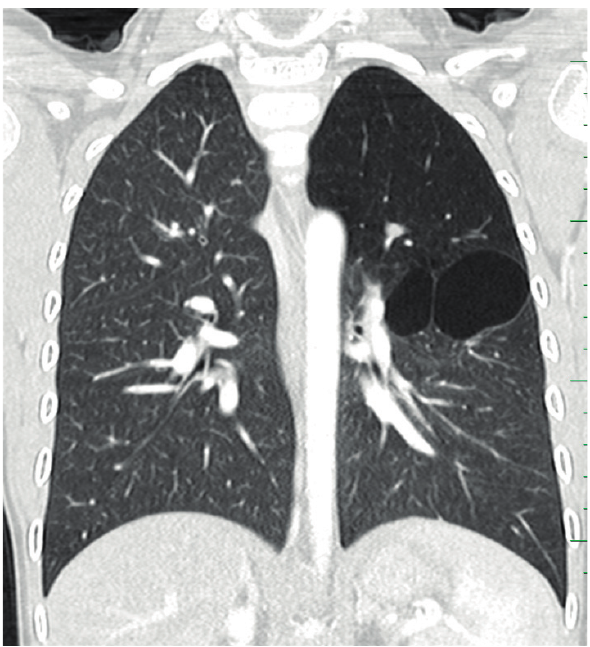
Fig. 2. Multiple large cysts measured > 2 cm in the left upper lobe (LUL), with adjacent area of hypoattenuation, mixed lesion with CPAM 1 and CLO component. Coronal postcontrast CT reconstruction, lung window.